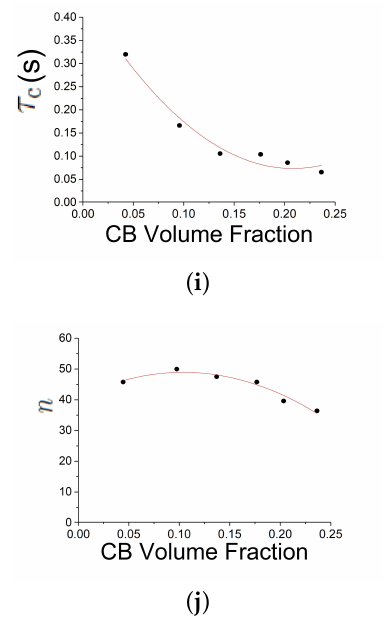
Figure 10. Trend of he parameters with the true carbon black filler volume V f . Subfigures ( a – j ) show respectively the trend of G c , G e , X max,0 , χ , C , c 1 , c 2 , φ , τ c and n .